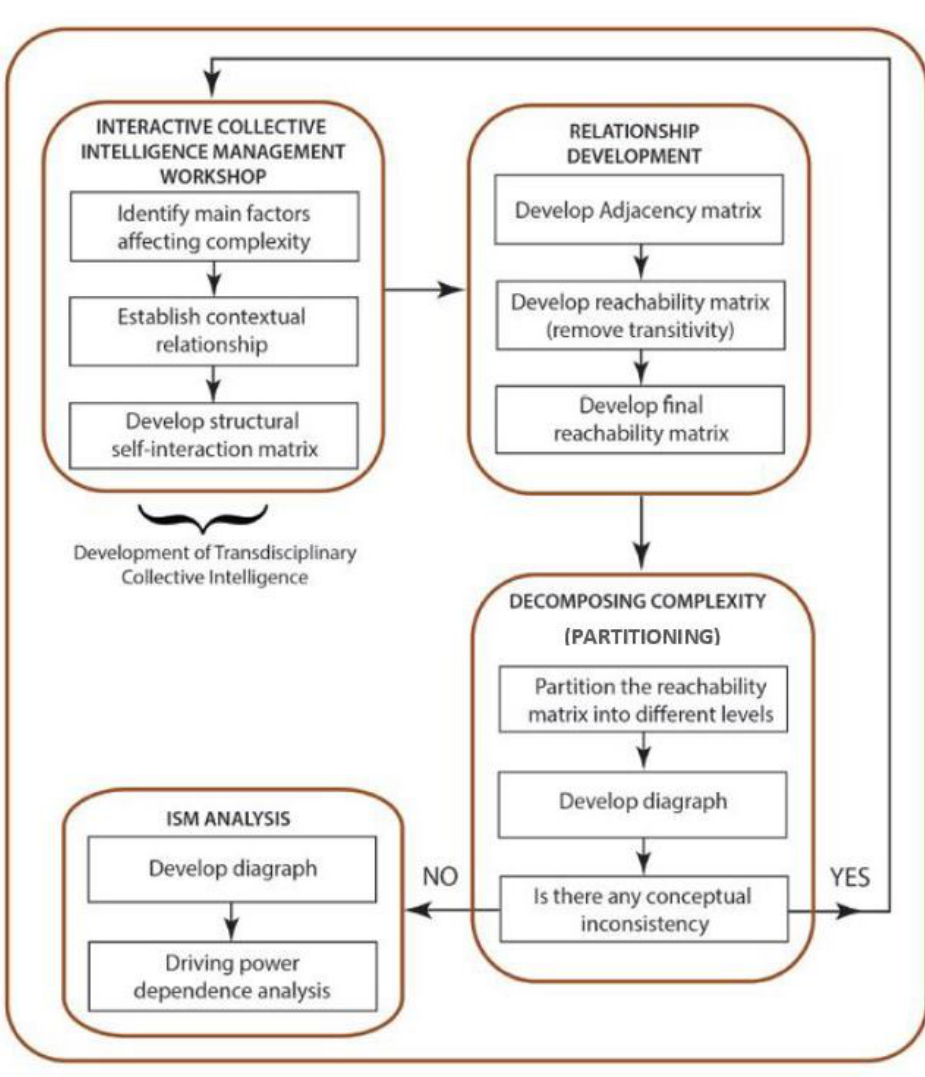
Figure 25. Interpretive Structural Modeling Process Overview